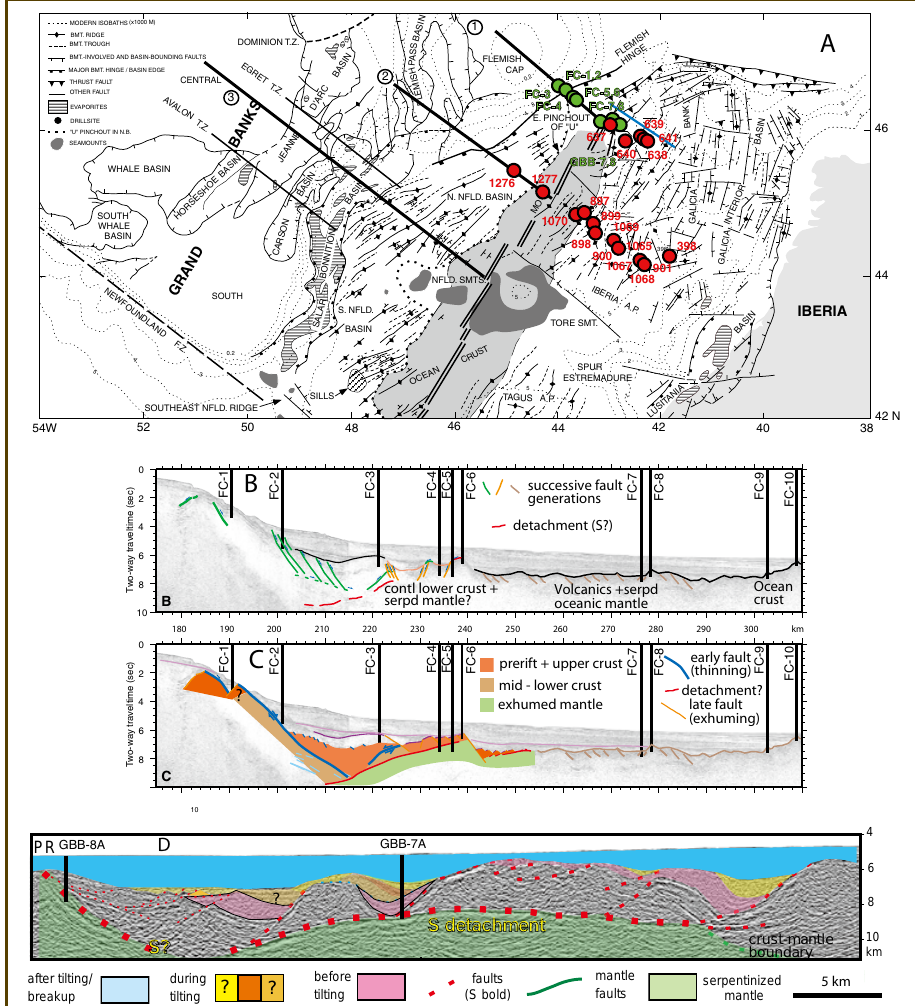
Figure 8. Summary of proposed drilling on the conjugate Newfoundland-Iberia hyper-extended margins. [A] Reconstruction of Iberia to Newfoundland at magnetic anomaly M0 time (124.5–125 Ma) (Srivastava et al., 2000). Red numbered dots are drill sites from ODP Legs 103, 149, 173, and 210. Green lettered dots are proposed drill sites in proposal 692 (FC-X) and proposal 657 (GBB-X). FC-8A to FC-10A are on crust younger than M0 and therefore are not shown. Thick lines labeled 1, 2, and 3 are the main SCREECH (Study of Continental Rifting and Extension of the Eastern Canadian shelf) transects along which both seismic reflection and refraction data were collected. Location of profile in part [D] is shown in blue. Figure adapted from Tucholke et al (2004). [B], [C]. Alternative interpretations of SCREECH 1 (Hopper, pers. comm.) showing location of drill sites which will test these and other models of breakup. [D] Depth image of Galicia margin (Reston et al., 2007) showing hypothesized detachment fault S beneath block- bounding faults. Drilling here will constrain nature and mechanics of S, age of overlying synrift wedges and evolution of mantle